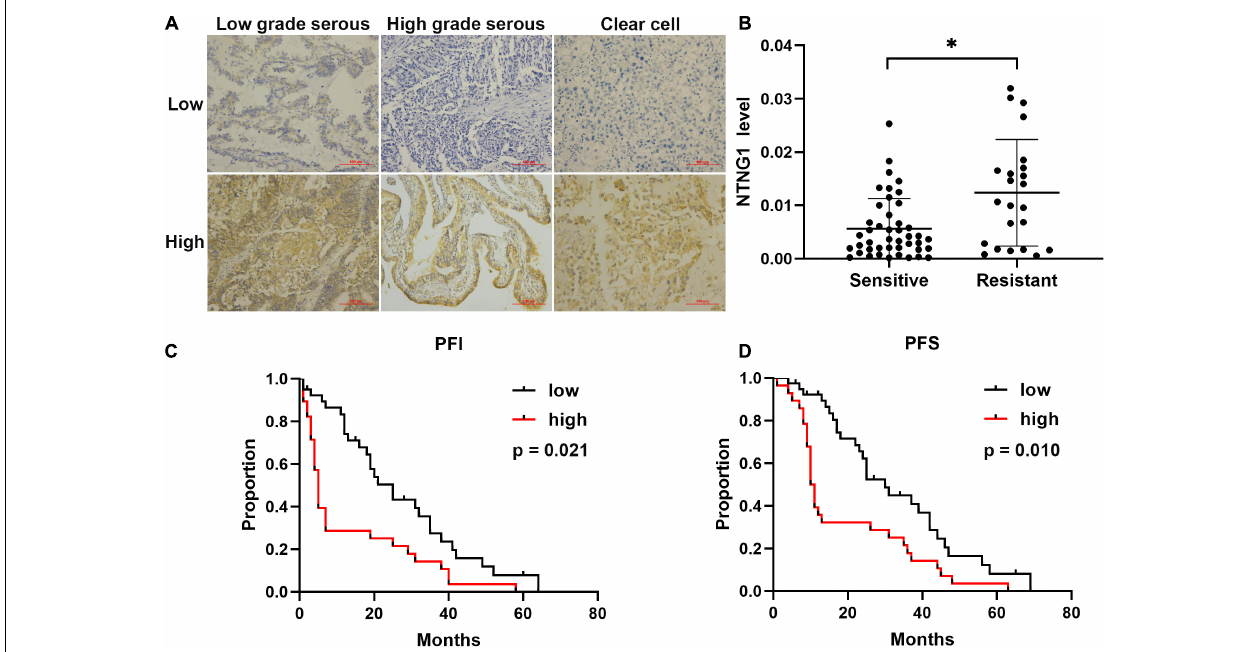
FIGURE 1 | Level of correlated with cisplatin response and prognosis in patients with ovarian cancer ( n = 67). (A) Representative immunohistochemical images of NTNG1 protein in cancer tissues; scale = 100 µ m. (B) Expression level of NTNG1 in cisplatin-sensitive or -resistant cancer tissues; a higher level was observed in resistant cancers. (C,D) Kaplan–Meier analyses of platinum-free interval (PFI) and progression-free survival (PFS); patients with a high NTNG1 level in cancer tissues had shorter PFI and PFS compared with those with a low level. ∗ p < 0.05.